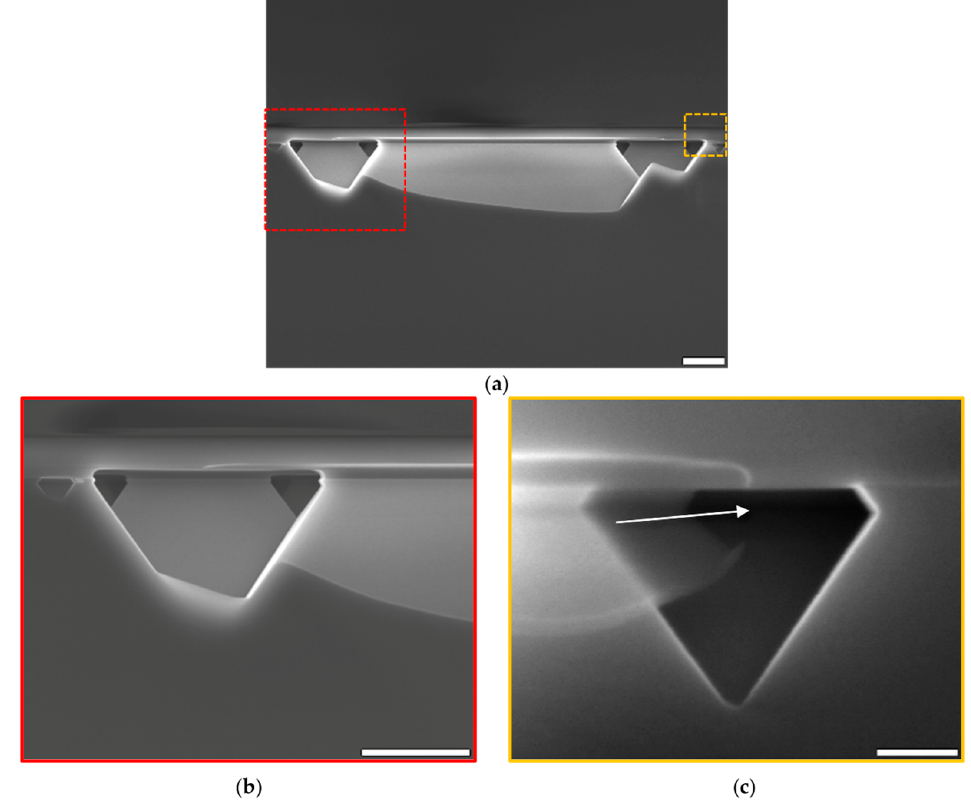
Figure 15. Cross-sectional SEM view of the second (G2), third (G3), and fourth generation (G4) fractals. The cross-section is made by breaking the sample. The diagonal bent lines at the bottom are caused by the break line being not fully parallel to the crystalline lattice for taking the cross-section SEM images. The white arrow in ( c ) indicates in which direction etchants went through the “nozzle” in the apex of the G3 to etch the G4. Enlarged areas are indicated in red and orange dashed lines. Scalebars: ( a , b ) 1 µm and ( c ) 100 nm.